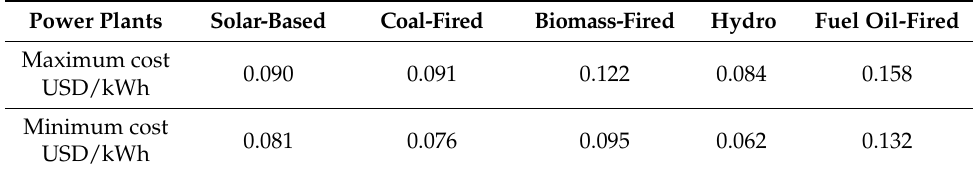
Table 1. Purchasing cost of electricity in Cambodia in 2020. Power